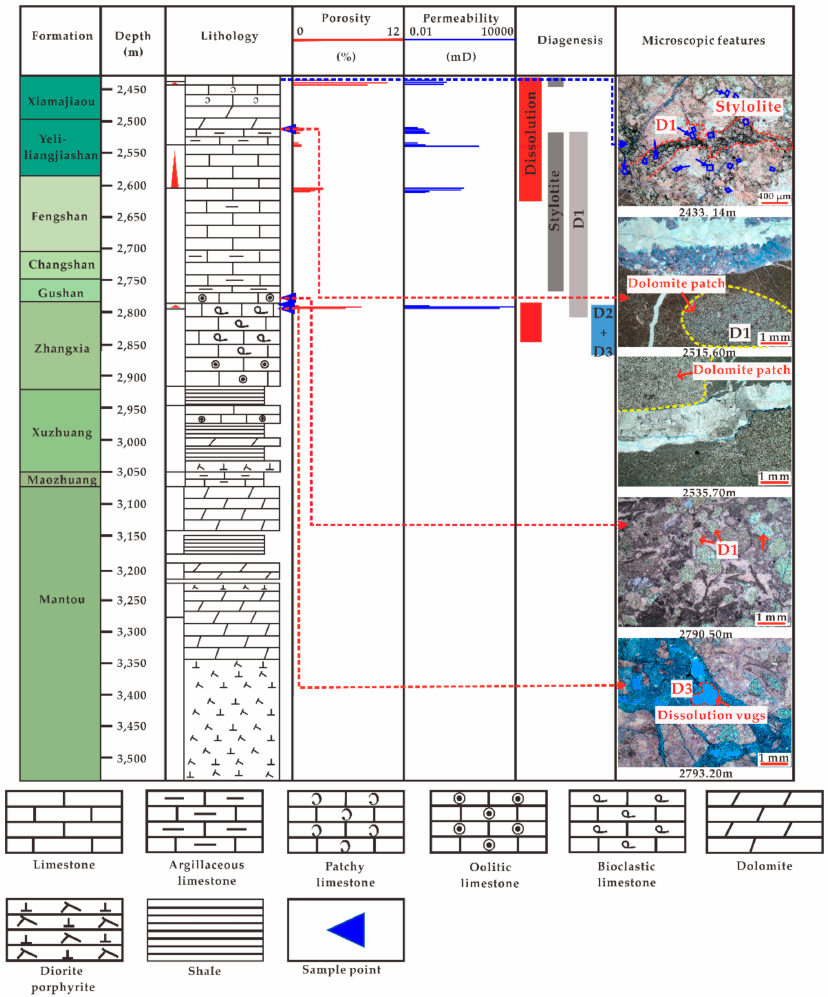
Figure 15. Differences of diagenesis in different strata in well Bg 26. D1: powder-to-fine-crystalline dolomite cements; D2: fine-crystalline ferroan dolomite cements; D3: medium-to-coarse-crystalline dolomite